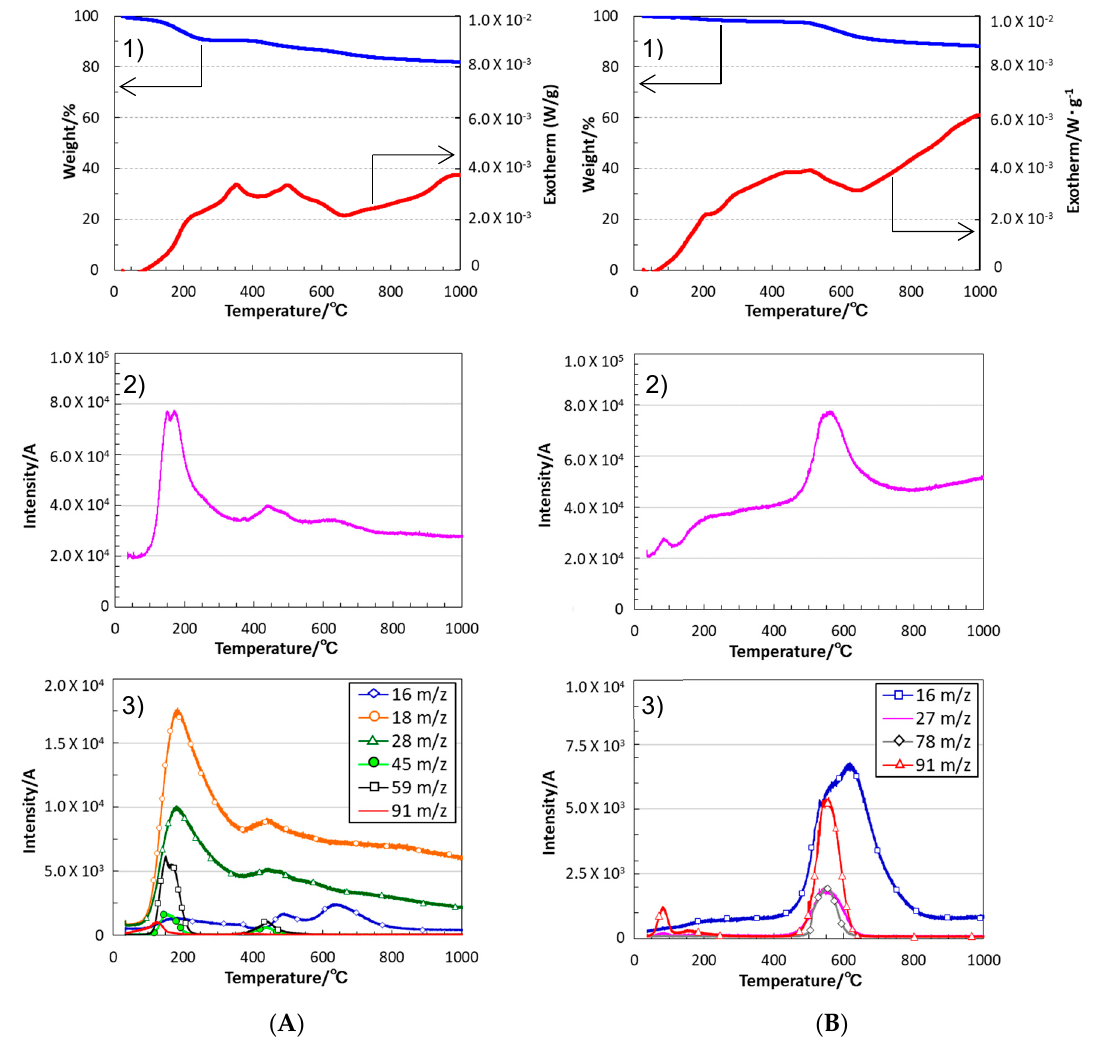
Figure 5. Thermal behavior of ( A ) VH-SQ and ( B ) St-H-SQ under a He flow. (1) TG/DTA curves, (2) total ion current chromatogram (TICC) detected for the gaseous species formed in situ, and (3) continuous in situ monitoring of the evolved gaseous species by mass spectroscopy.